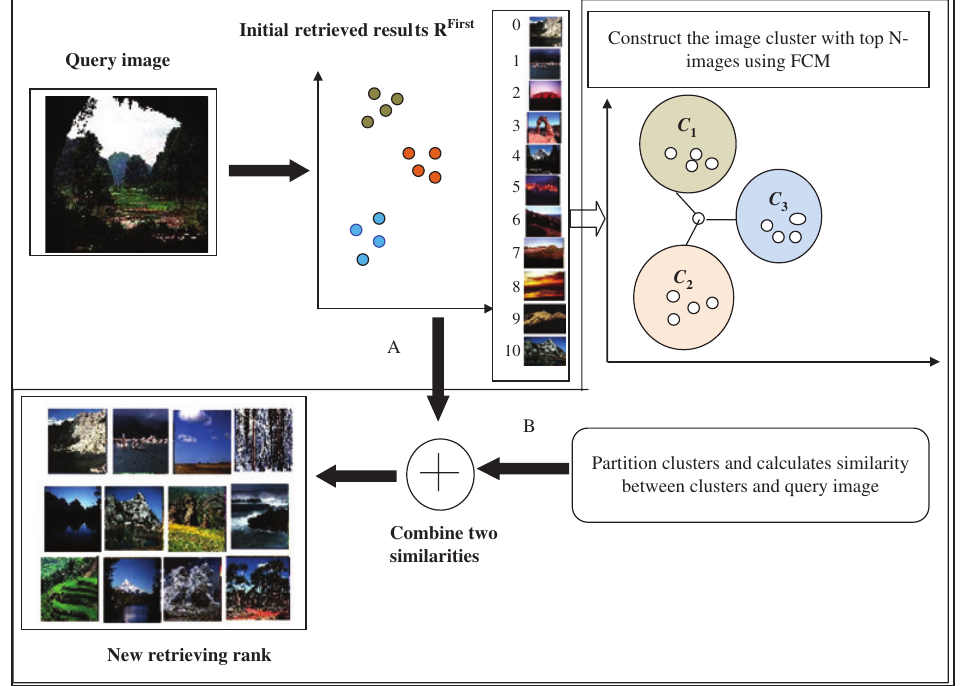
Figure 3: Re-evaluating